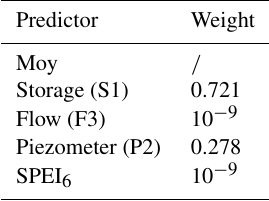
Table 2. Weights of the linear model calibrated for the optimal sub- set of predictors. The predictor Moy (month of the year), providing seasonal information, is not directly included in the weights opti- mization but it is accounted for by subtracting the annual cyclo- stationary mean from the predictors time